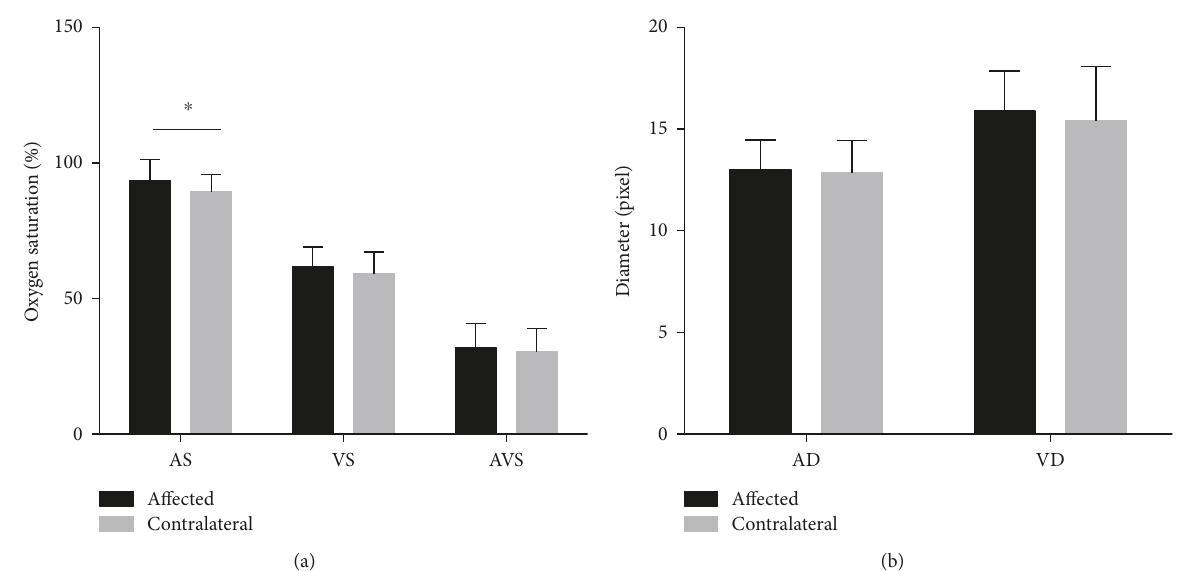
Figure 3: Oxygen saturation and vessel diameters around the macular area. (a) Compared to the contralateral eyes, AS is increased in the a ff ected eyes ( p value of 0.006), but AVS shows no signi fi cant di ff erence. ∗ p < 0 05 (AS: Wilcoxon matched pair signed rank sum test; VS, AVS: paired t -test). (b) Vessel diameters show no change. ∗ p < 0 05 (paired t